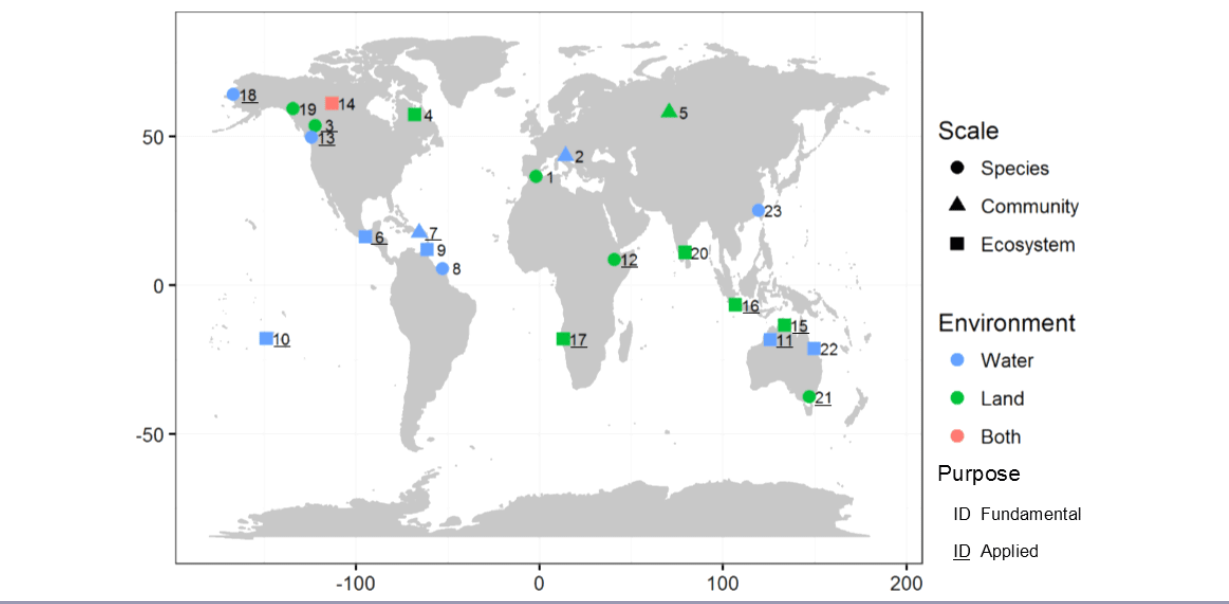
Fig. 2 . Spatial distribution, organization scale, type of environment, and purpose of the 23 published studies (identification numbers refer to the studies listed in Appendix